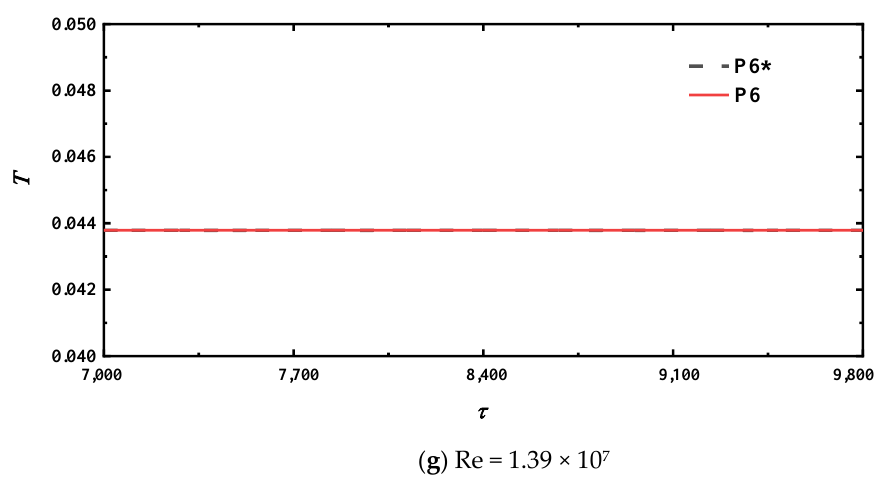
Figure 4. Temperature time series and PSD of the mixed convection at P6, P6* with different Re.